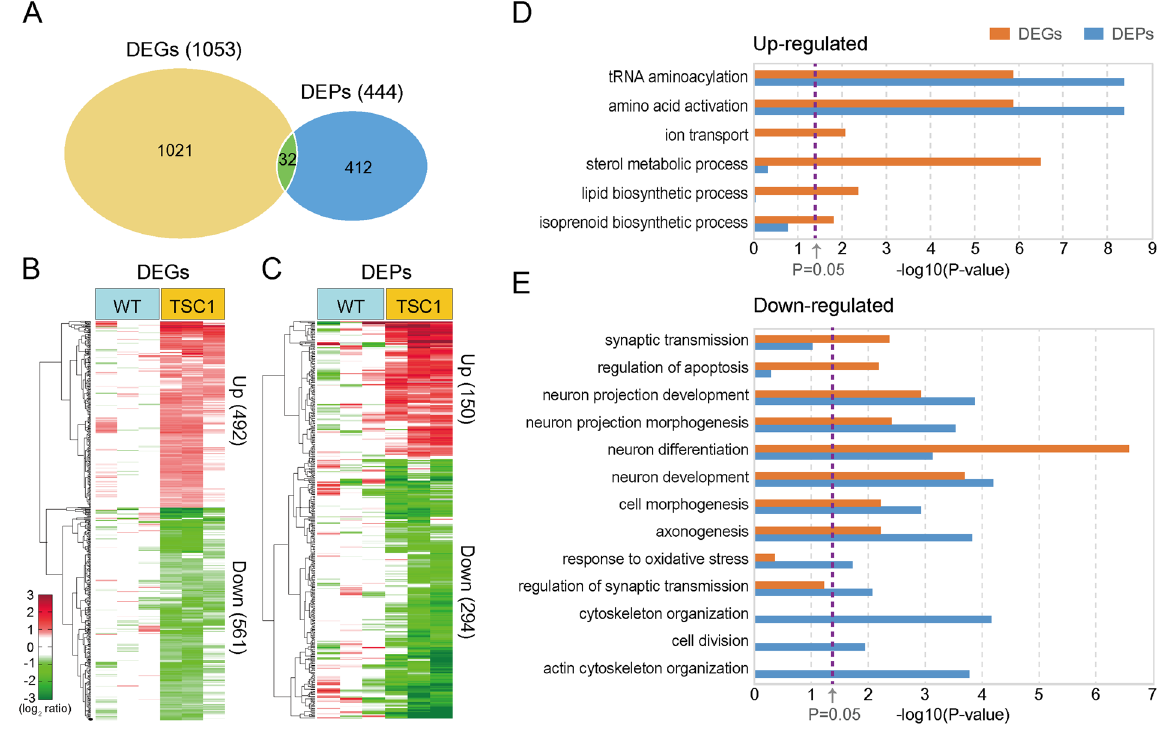
Figure 2. Genes and proteins altered by hyperactivated mTOR signaling. ( A ) Relationships between DEGs and DEPs by hyperactivated mTOR signaling. Numbers in parentheses denote the numbers of DEGs and DEPs. ( B , C ) Heat maps showing up- (Up, red) and down-regulation (Down, green) of DEGs ( B ) and DEPs ( C ) between WT (1 st to 3 rd columns) and TSC1 CKO (4 th to 6 th columns) samples. The color bar represents gradients of log 2 -fold-changes between TSC1 CKO and WT. Numbers in parentheses denote the numbers of up- and down-regulated genes or proteins. ( D , E ) GOBPs represented by up- ( D ) and down-regulated ( E ) genes (orange) or proteins (blue). The significance of GOBPs enriched by DEGs or DEPs was displayed by –log 10 ( P ) where P is the enrichment P-value obtained from DAVID software. The color bar denotes gradients of –log 10 ( P ). The cutoff of P-value (P = 0.05) was indicated by the dotted